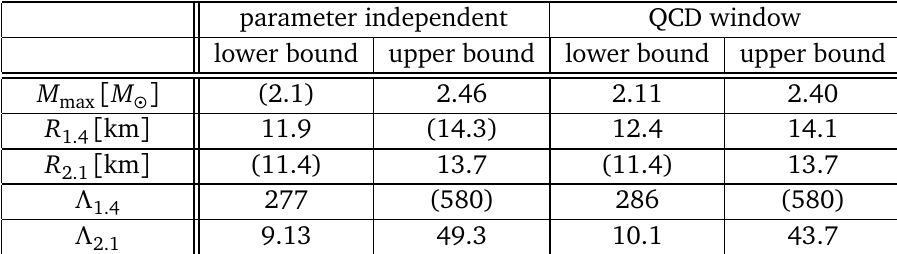
Table 2: Constraints obtained by combining the holographic results with astrophysi- cal data for maximal mass as well as radius and tidal deformability for 1.4-solar-mass and 2.1-solar-mass stars. Parameter-independent bounds are valid for any model pa- rameters λ , M , while the QCD window defined by table 1 and Fig. 4 gives tighter KK bounds. Parentheses indicate that our model does not further restrict the astrophys- ical data used here. parameter independent QCD window lower